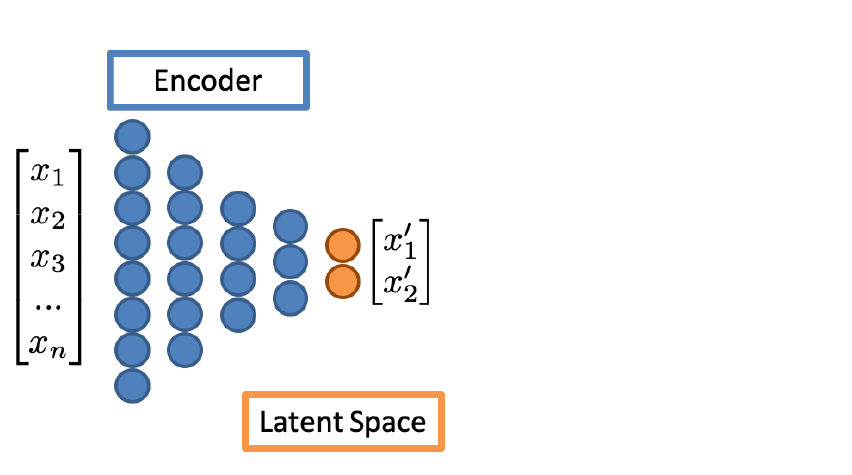
Figure 2. Encoder with latent space output highlighted in orange. When applying autoencoders for dimensionality reduction, the decoder section of the trained neural network is removed and the output of the latent space is analyzed directly.